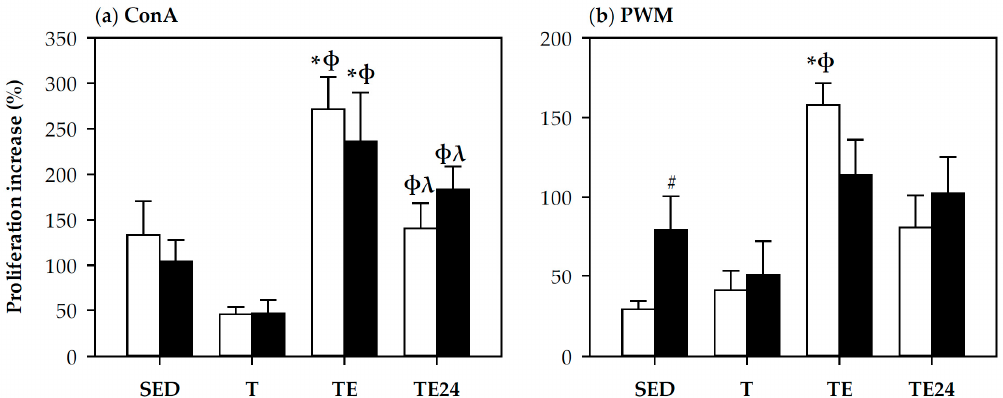
Figure 4. Proliferation capacity of spleen T lymphocytes ( a ) and B lymphocytes ( b ). The non- supplemented groups are represented by white bars and the hesperidin-supplemented groups by black bars. SED = sedentary groups; T = trained groups; TE = T groups with an additional exhaustion test;